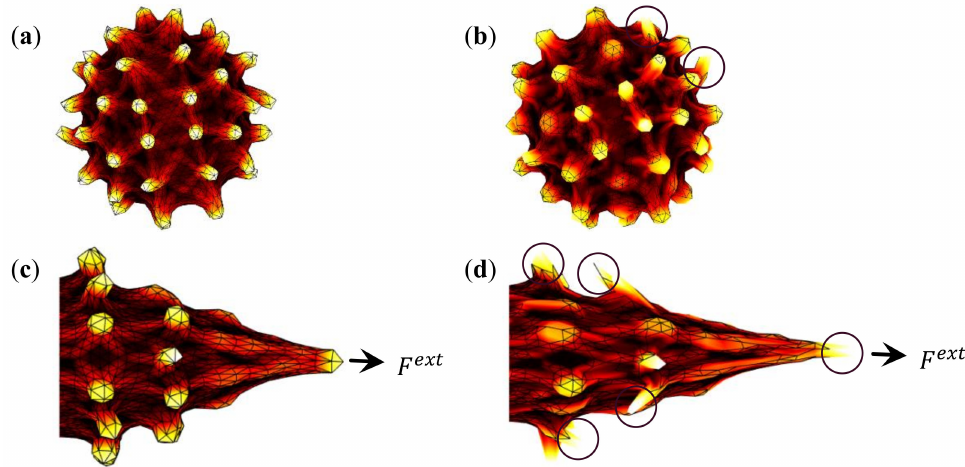
Figure 9. The equilibrium cell shapes of day 42 sphero-echinocytes with ( a ) A Vertical = 0% and ( b ) A Vertical = 25%, and the stretched cell state of ( a , b ) under optical tweezers stretching forces of F ext = 200 pN; ( c , d ), respectively. The lines in black on the cell surface indicate the membrane surface supported by the cytoskeleton. The circled regions in black on day 42 sphero-echinocytes with A Vertical = 25% indicate the sharp projections on the cell